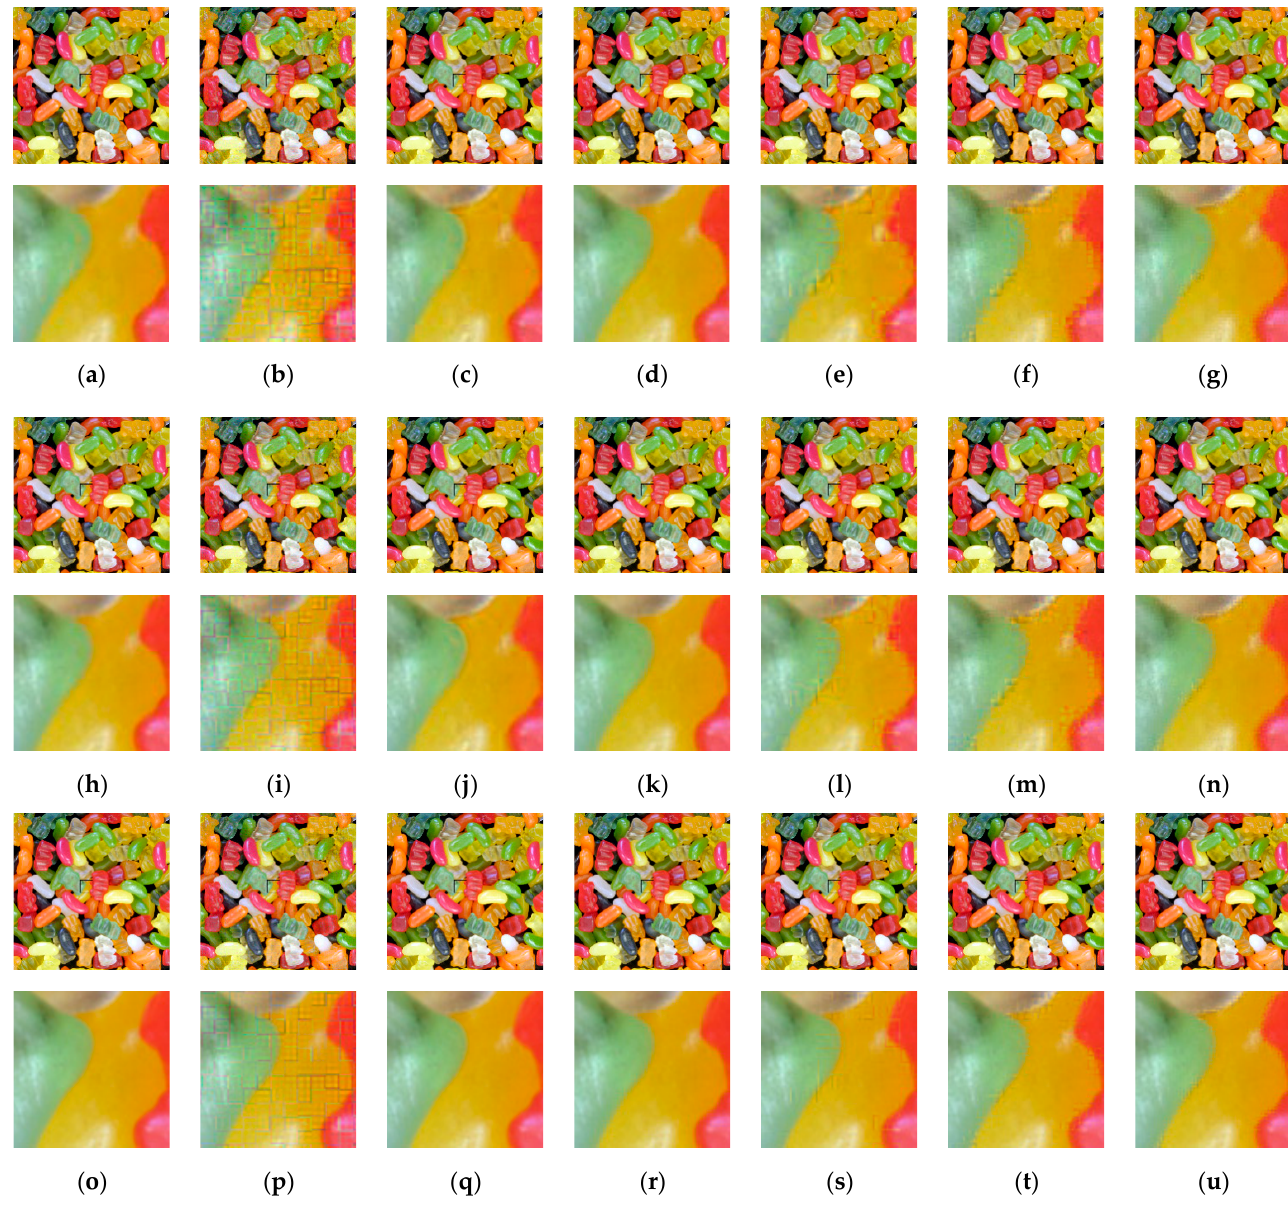
Figure 10. Visual analysis of the images recovered from the CPE processing. The JPEG algorithm with chroma subsampling (4:2:0) and the CPE were implemented on the image given in Figure 9. ( a ) The recovered image from the compression of plain image. ( b – g ) The recovered images from the compression of cipher images obtained from the Color CPE (8 × 8), Color CPE (16 × 16), PGS–CPE, IIB–CPE (8 × 8), IIB–CPE (4 × 4), and IIB–CPE (2 × 2) methods, respectively. The images recovered were compressed with the JPEG 𝑞𝑓 = 71 in ( a – g ), 𝑞𝑓 = 85 in ( h – n ), and 𝑞𝑓 = 100 in ( o – u ). For each image, the boxed region is zoomed in and shown below them. For the grayscale image visual analysis, Figure 11 shows an example image from the USC–SIPI dataset and its cipher images (b–d) obtained from GS–CPE and GS–IIB–CPE methods. For visual analysis, the square bounded area in each image is zoomed in and shown below its corresponding image. It can be seen that the global contents of the image are scrambled. Owing to the sub-block processing, the GS–IIB–CPE method achieved be tt er visual encryption of the local details. The cipher images were compressed using the JPEG algorithm under di ff erent quality factors, and their corresponding recovered images are shown in Figure 11e–p. During compression, the quality factor was set to 𝑞𝑓 = 71 in Figure 11e–h, 𝑞𝑓 = 85 in Figure 11i–l, and 𝑞𝑓 = 100 in Figure 11m–p. The images recovered from the cipher images have the same visual appearance as the recovered plain images.